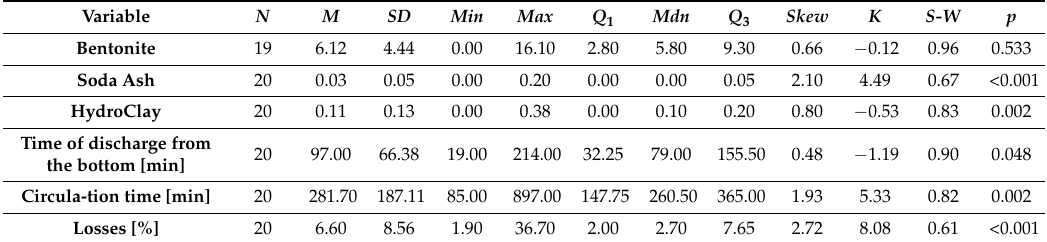
Table 6. Characteristics of the level of the analyzed variables in the tested sample ( N =